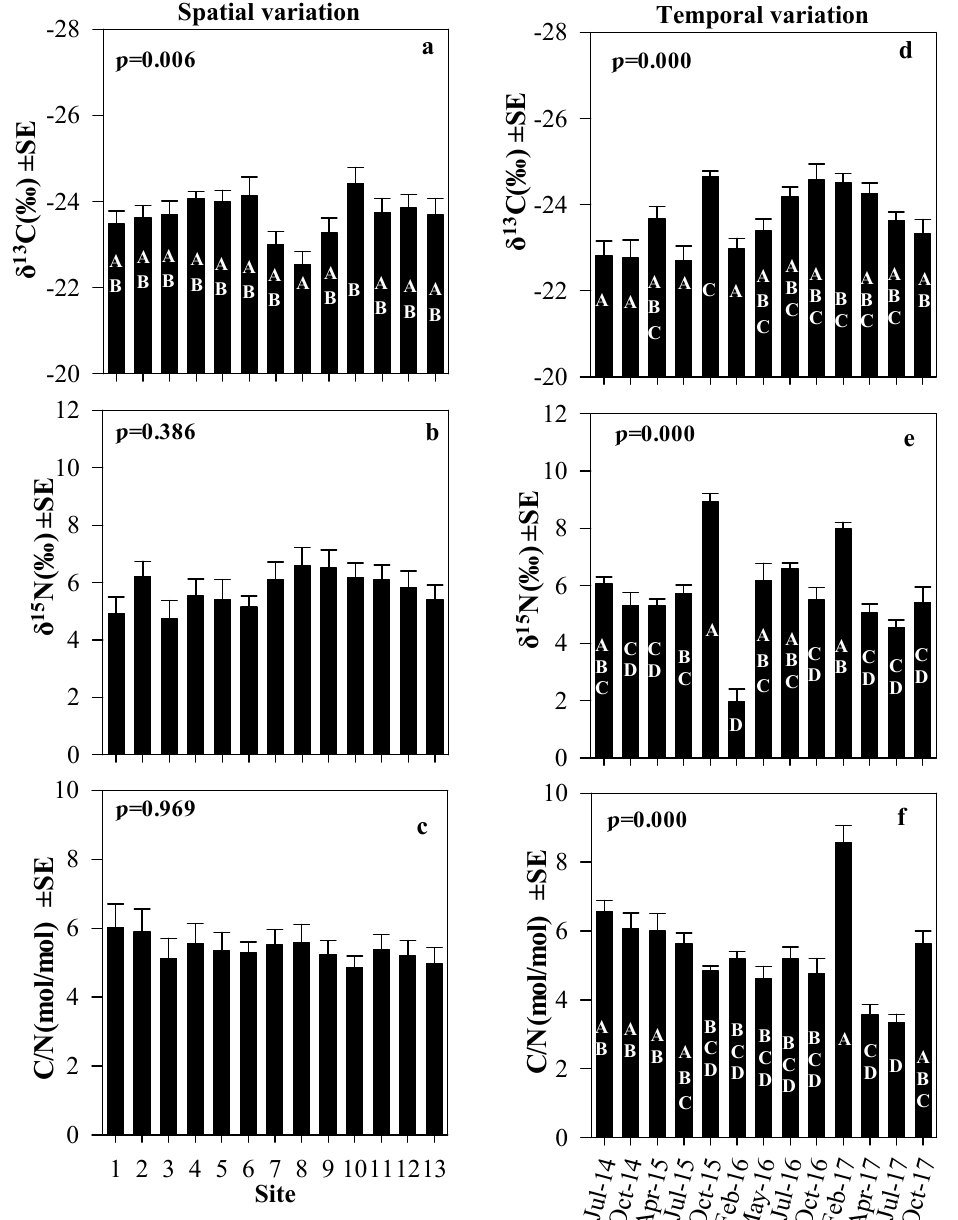
Figure 5. Left: Spatial variation of δ 13 C ( a ), δ 15 N ( b ) and C:N ( c ) SPOM (suspended particulate organic matter) values and, right: temporal variations of δ 13 C ( d ), δ 15 N ( e ) and C:N ( f ) SPOM values